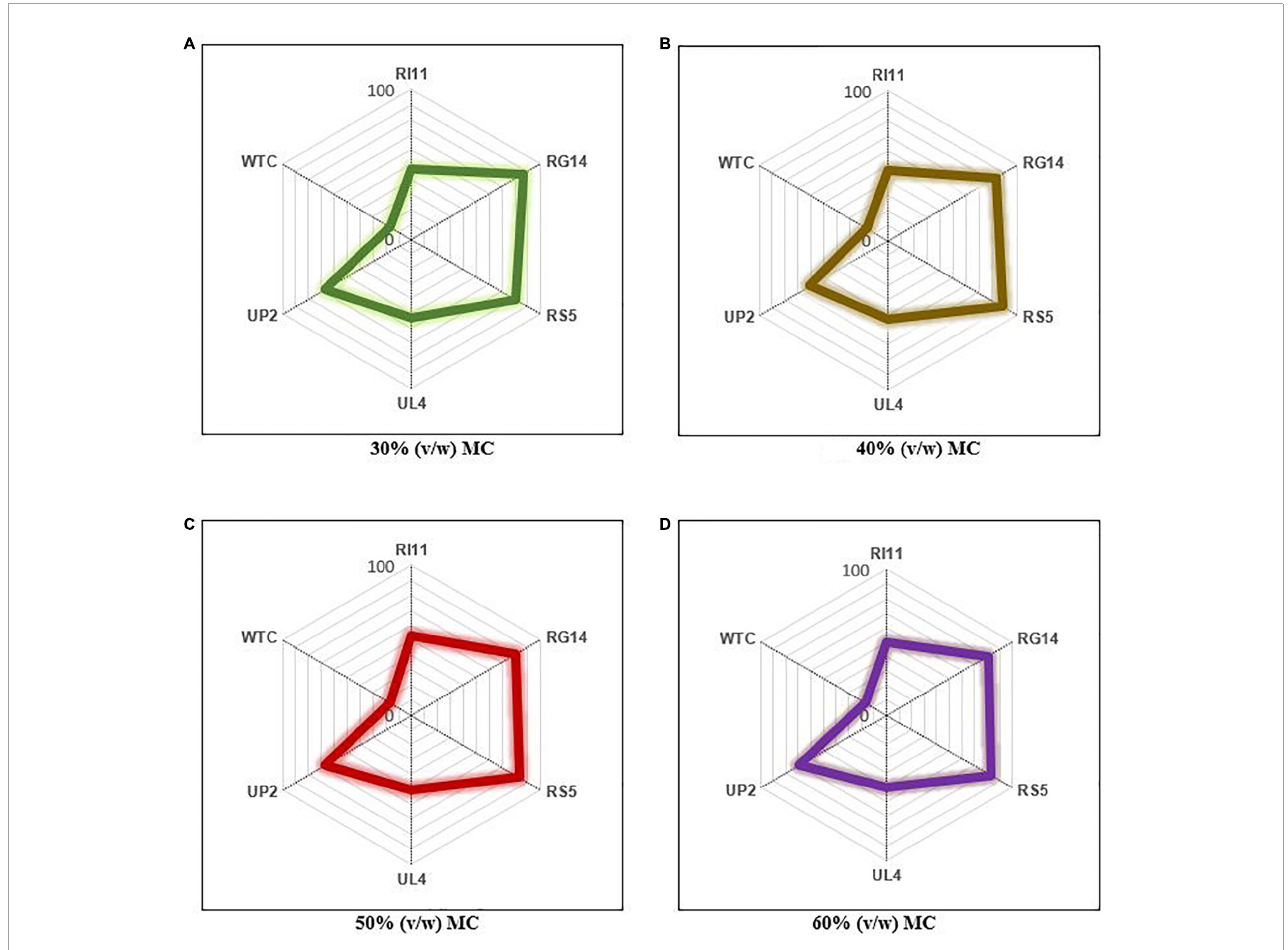
FIGURE6 Ranking of the overall performance of probiotics at 30–60% (v/w) moisture contents for the biotransformation of composite flour via solid-state fermentation for 7 days. WTC, water- treated control; R111, L. plantarum RI11; RG14, L. plantarum RG14; RS5, L. plantarum RS5; UL4, L. plantarum UL4; UP2, P. pentosaceus UP2. (A) 30% (v/w) moisture content, (B) 40% (v/w) moisture content, (C) 50% (v/w) moisture content, (D) 60% (v/w) moisture content. The percentage score of each strain represents their performance. The strain with the highest score at each moisture content is considered